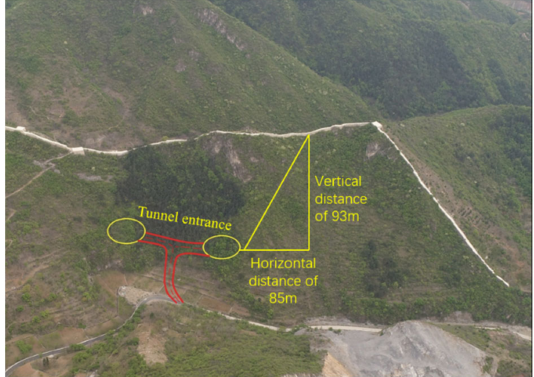
Figure 14. The site location of the entrance of Longmen Tunnel and the Great